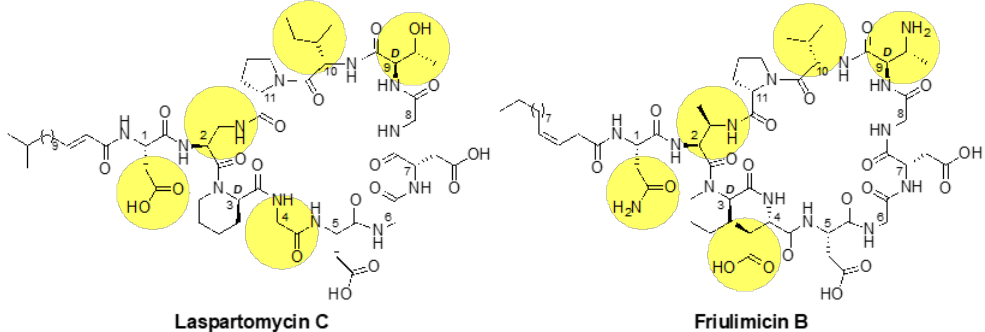
Figure 2. Structures of laspartomycin C and friulimicin B. The lipid tails of the two lipopeptides di ff er, as laspartomycin C bears a 15-carbon tail containing a trans alpha-beta unsaturated moiety while friulimicin B contains a 14-carbon cis -beta gamma unsaturated lipid. Other notable di ff erences include the amino acids at positions 1, 2, 4, 9 and 10 (highlighted), which are Asp, diaminoproionic acid (Dap), Gly, d - allo -Thr, and Ile, respectively, in laspartomycin C and Asn, 2 S ,3 R -diaminobutyric acid (Dab), l - threo -3-methyl-aspartate (MeAsp), 2 R ,3 R - d -Dab and Val, respectively, in friulimicin